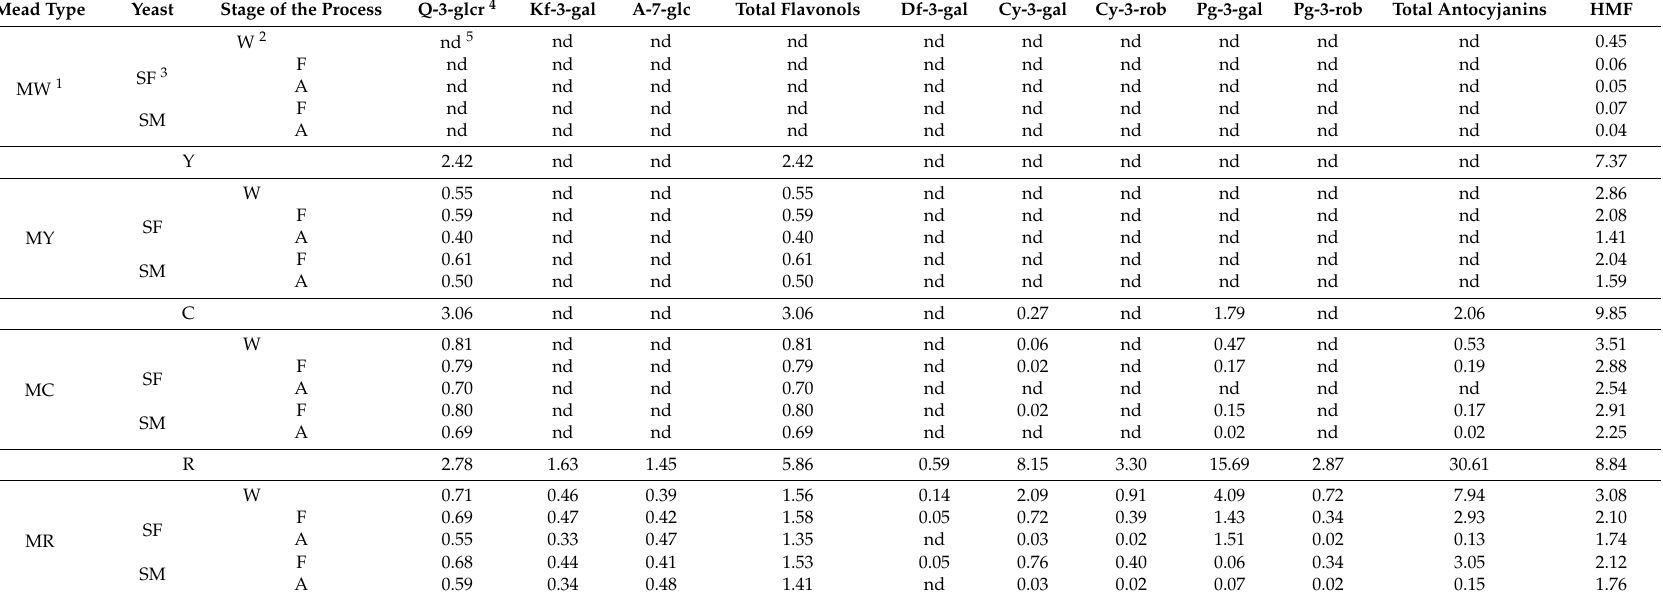
Table 4. Flavonols, anthocyanins, and hydroxymethylfurfural content (mg/L) in mead samples (MW, MY, MC, MR) at different stages of their production: worts (W), samples after alcoholic fermentation (F), and meads after aging (A), fermented with different yeast: S. bayanus Safspirit Fruit (SF), S. cerevisiae Safspirit Malt